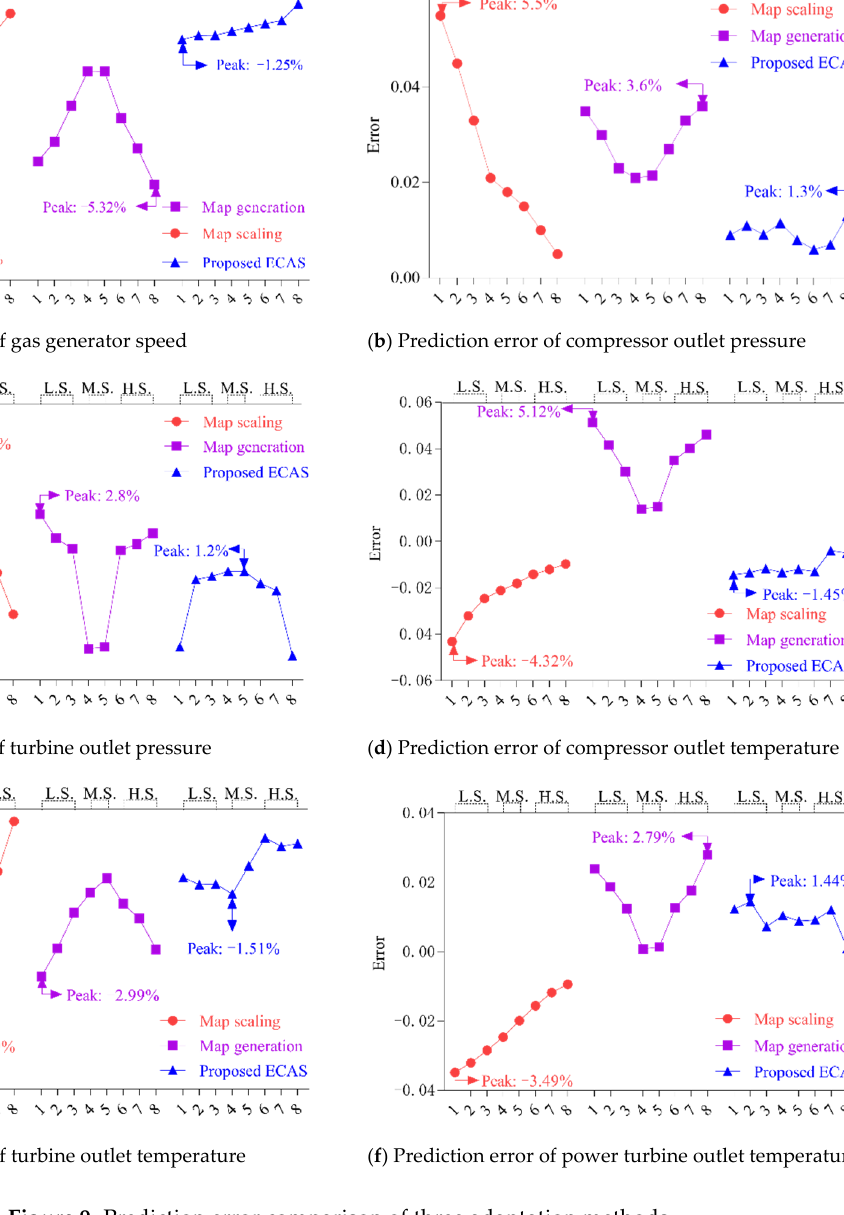
Figure 9. Prediction error comparison of three adaptation methods.